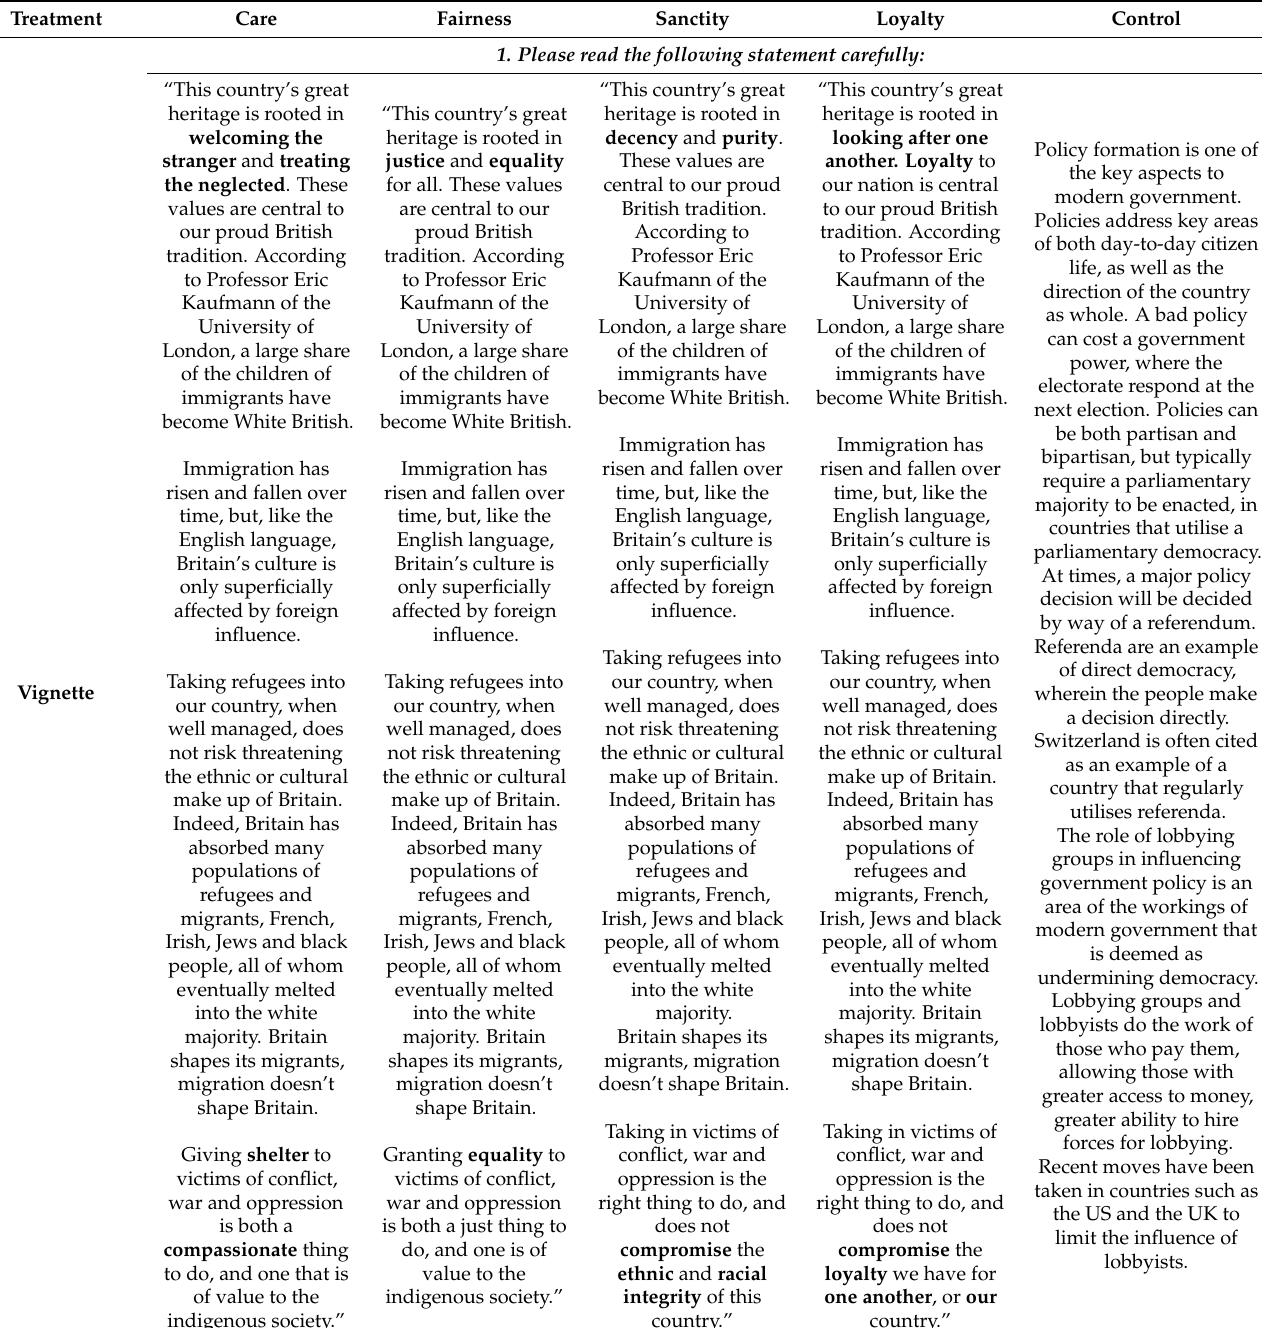
Table A2. Treatment